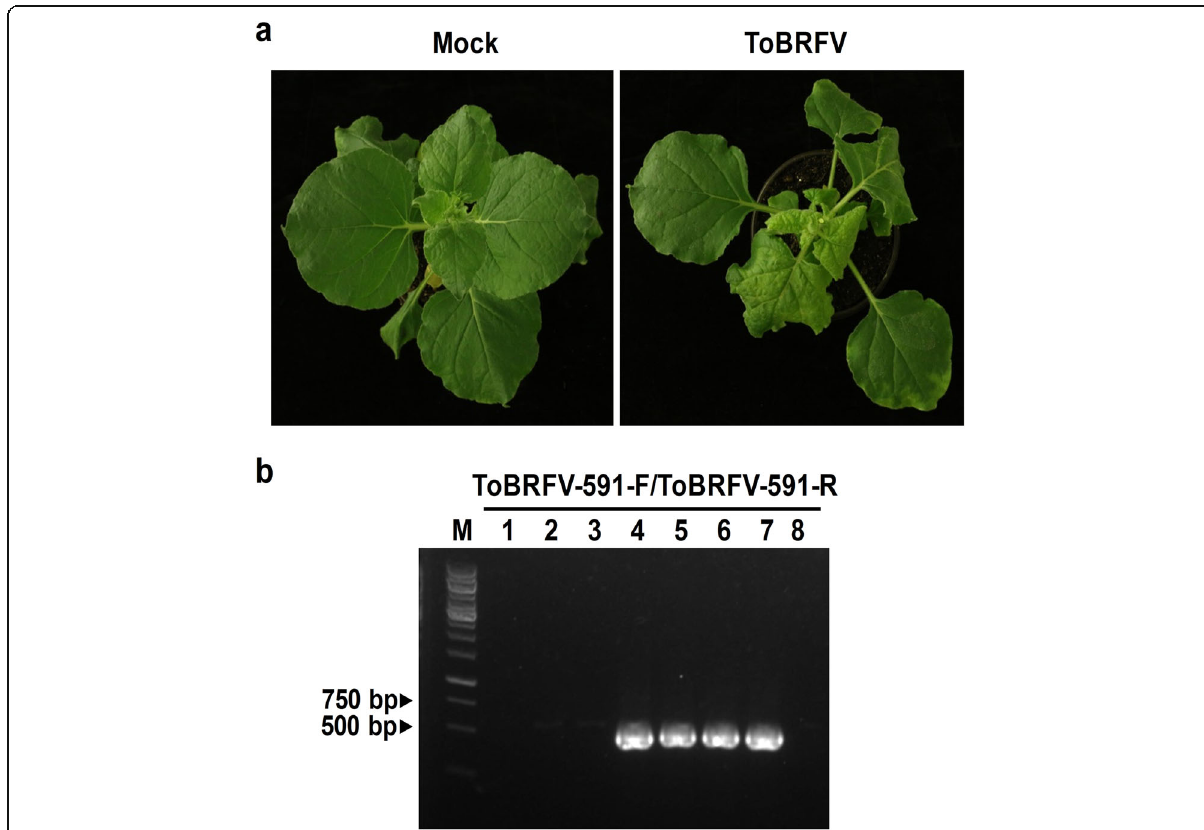
Fig. 5 Sap transmission of ToBRFV particles produced in tomato plants infected with the infectious clone of ToBRFV. a Symptom of N. benthamiana plant mechanically inoculated with crude sap extracted from systemic leaves of tomato plants agroinoculated with the ToBRFV infectious clone at 7 dpi. b RT-PCR detection of ToBRFV RNA accumulation in systemic leaves of mechanically inoculated N. benthamiana plants using ToBRFV-specific primers. Lane M, GeneRuler 1 kb DNA ladders (Thermo); lanes 1 – 3, samples mock-inoculated with PBS buffer; lanes 4 – 7, samples collected from systemic leaves of mechanically inoculated N. benthamiana plants; lane 8, ddH 2 O (negative